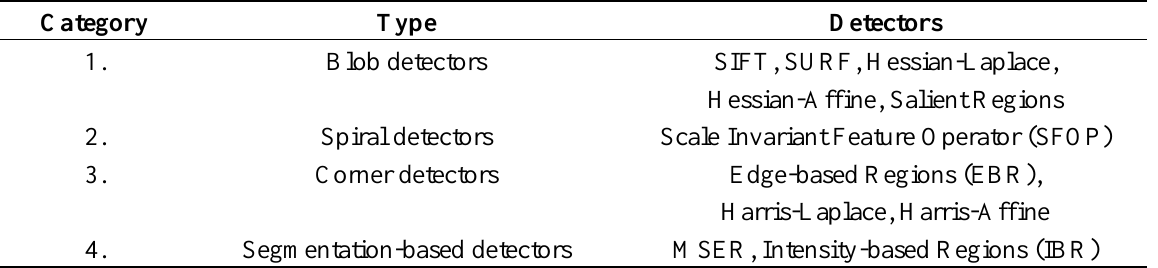
Table 3. A taxonomy of state-of-the-art feature detectors based on [1].